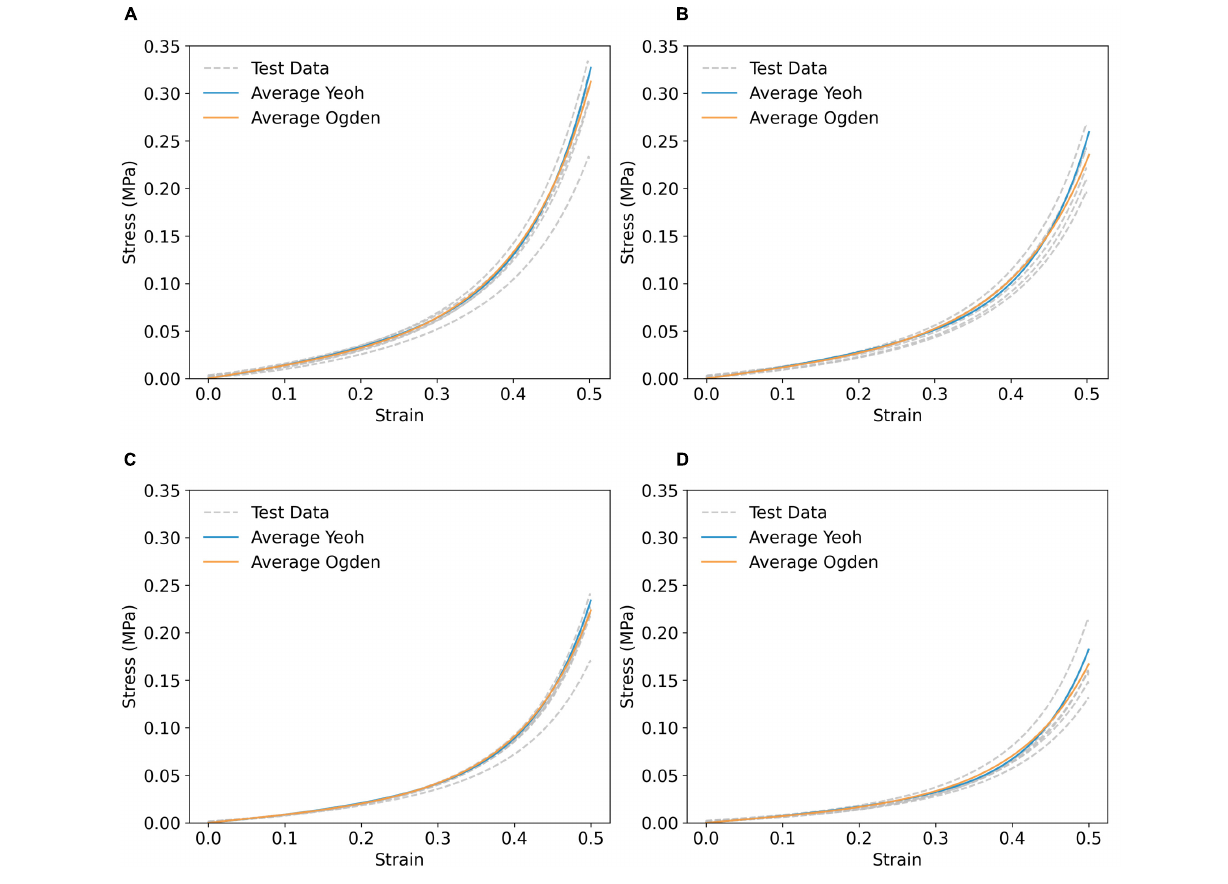
FIGURE 4 | Simulated compressive stress–strain response using averaged Yeoh (solid blue line) and first order Ogden (solid orange) parameters of (A) P 9 G 1 -A-C, (B)